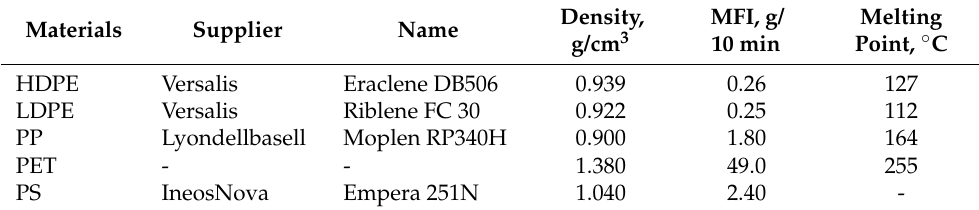
Table 1. Main characteristic of the polymers.